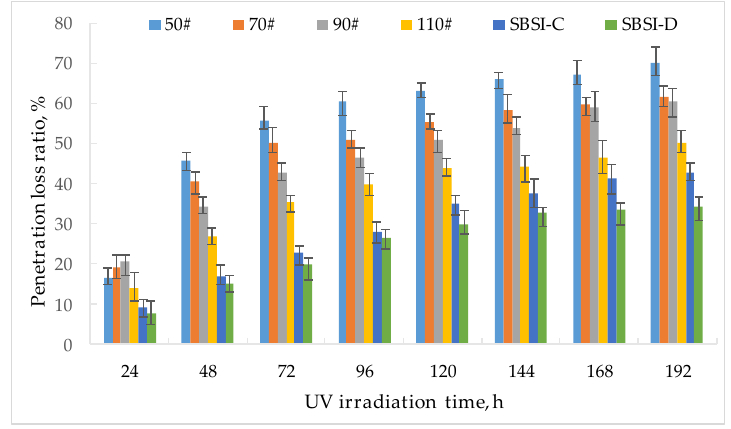
Figure 5. The penetration loss rate of asphalt with different UV irradiation time. With the extension of UV irradiation time, the penetration of asphalt obviously de- creased. From the point of decline, the lower the asphalt grade, the greater the decrease in penetration, but the absolute value of decrease was not very high. The decrease in pene- tration of SBS modified asphalt was obviously smaller than that of base asphalt, which shows that the anti-UV performance of SBS modified asphalt was better than that of base asphalt. In addition, the decrease in penetration of SBS I-D was lower than that of SBS I- C. Generally, 87.21% of the temperature interval between the dropping point and the hardening point was taken as the softening point. Soft point is generally considered as an indicator of the thermal stability of asphalt materials, and also a measure of the conditional viscosity of asphalt. Relevant data show that UV radiation can increase the softening point of asphalt [7–9]. In this paper, the ring and ball method was used to determine the softening point. Figure 6 shows the asphalt softening point at the UV irradiation intensity of 157.5 W/m 2 under different UV irradiation times. Figure 7 shows the softening point loss rate of asphalt under different UV irradiation times.